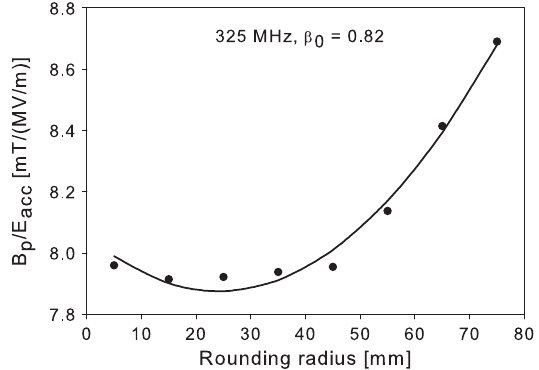
FIG. 32. Dependence of B p =E acc on the outer conductor edge rounding.